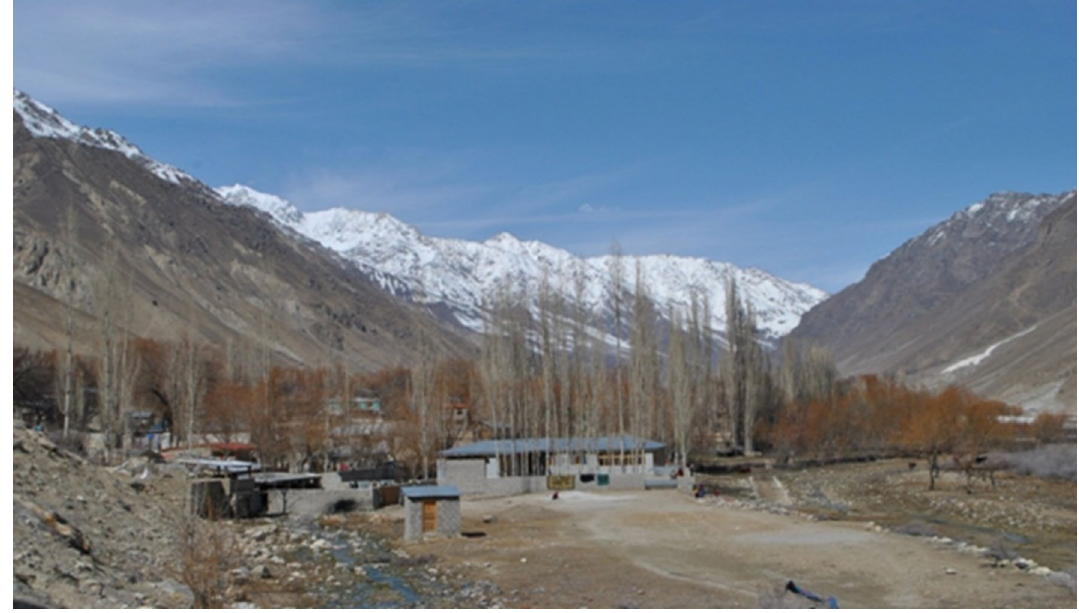
Fig. 1 Chutrun Hot Springs, Shigar Valley,